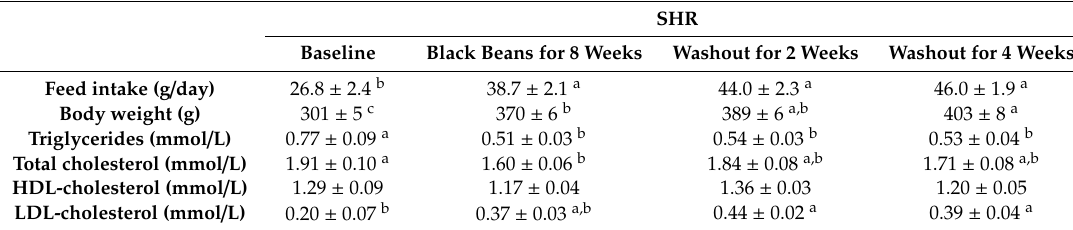
Table 5. Phase 2: Metabolic parameters.